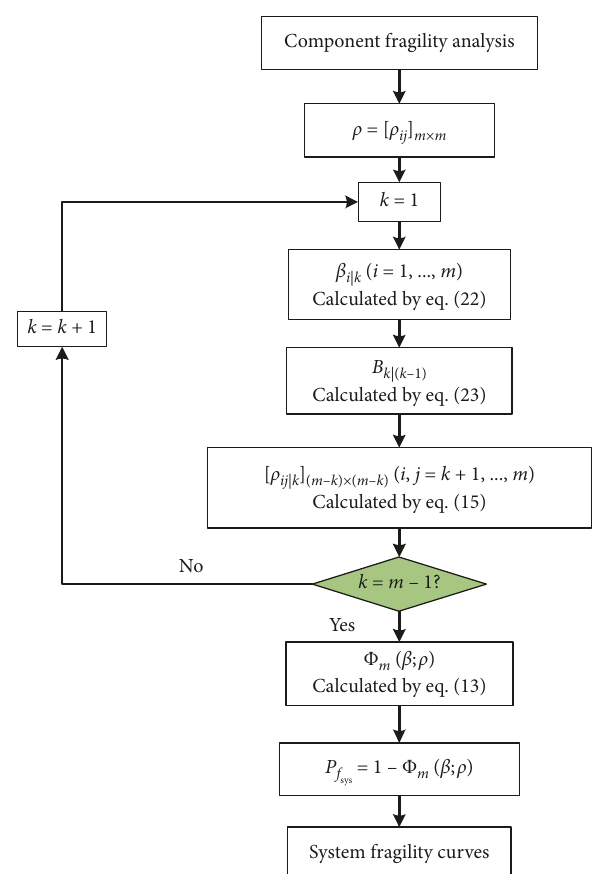
Figure 1: Flow chart of structural system fragility curves based on the improved